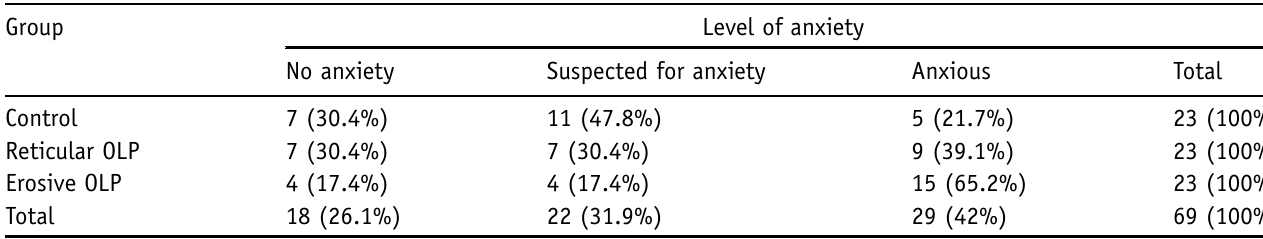
Table V. Frequency of different levels of anxiety in the three groups. Group